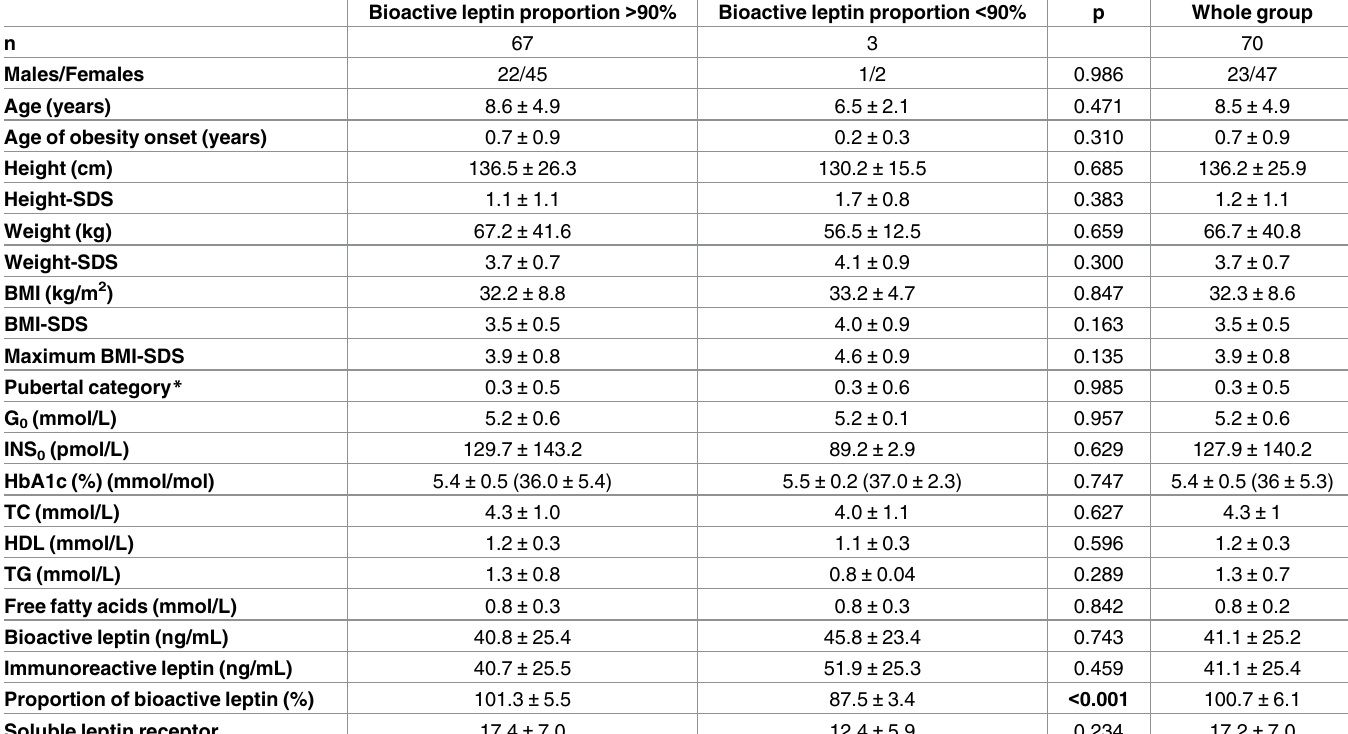
Table 1. Phenotype characterization of 70 early-onset severelyobese children and adolescents selected for the leptin